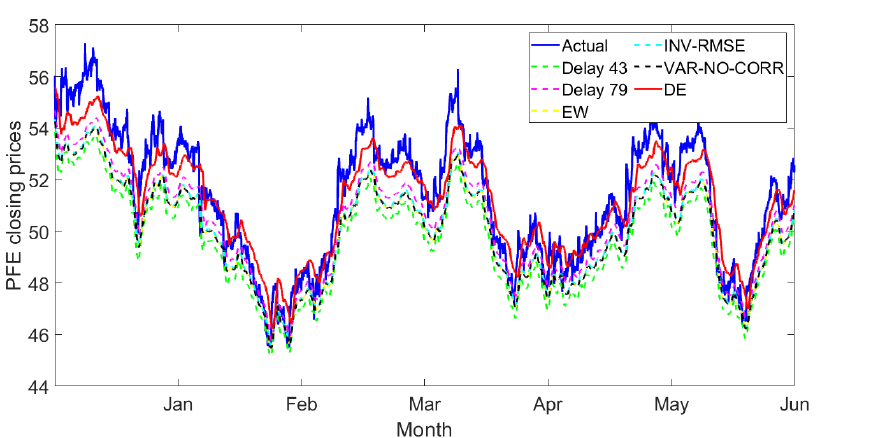
Figure 15. The forecasting curve for actual data versus the individual and combination methods of PFE stock obtained from CNN model between January and June